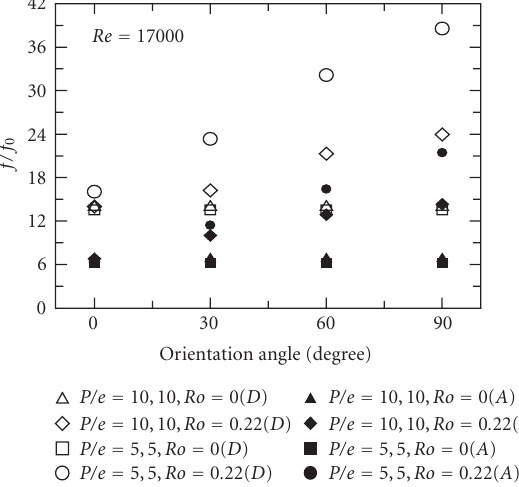
Figure 12: Comparison of friction factor in square channels with detached (D) and attached (A) rib configurations at Re =